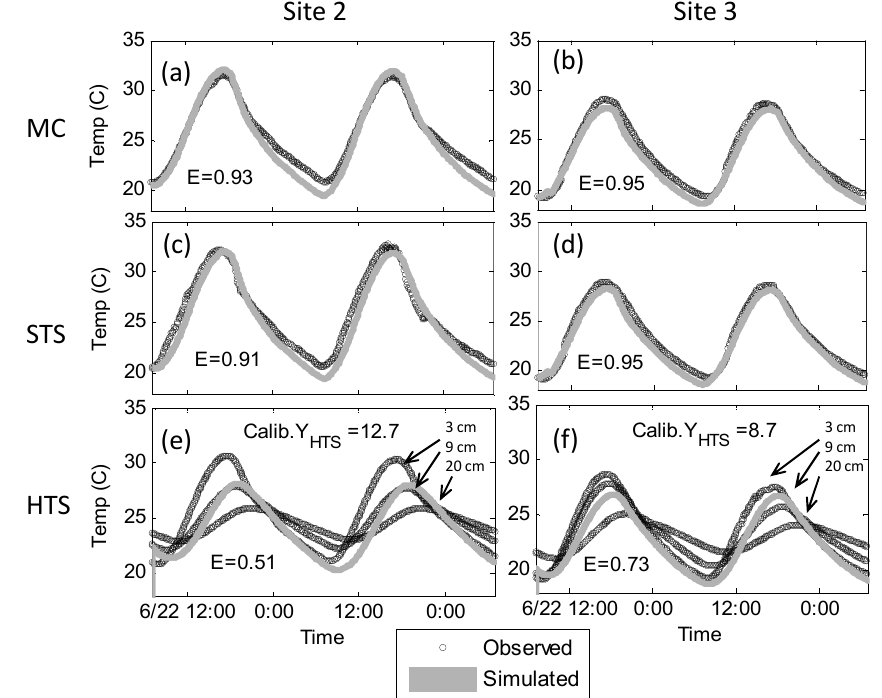
Fig. 3. Test 2 (Level 1) plots of temperature data for Site 2 and Site 3 in the main channel (MC) (a, b) , STS (c, d) , and HTS (e, f) . Test 2 met the local criteria ( E > 0.8), but not the global criteria (AE s > 0.7). E for each location is shown in each subplot. The calibrated hyporheic sediment depth ( Y HTS in cm) is shown in the HTS (e, f) with the observations at three depths labeled (3, 9 and 20cm). The temperature data sets closest to this Y HTS are used to calculate the E HTS since observations at multiple depths were available.